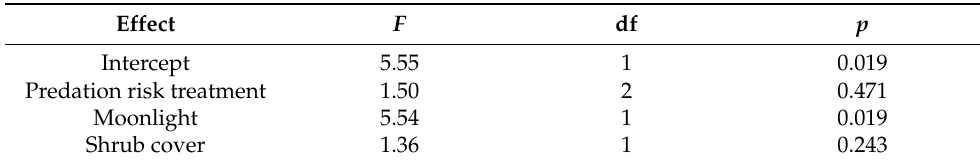
Table 4. Results of the GLM analyzing the effect of experimental and environmental factors on Abrothrix spp. vigilance behavior.